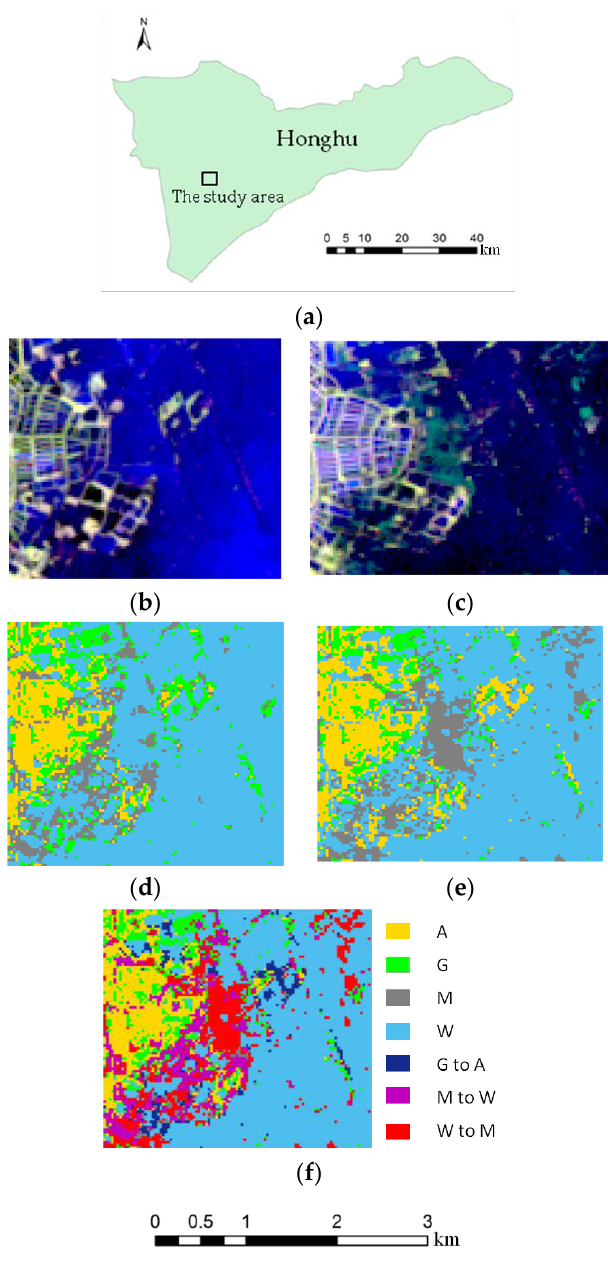
Figure 1. The study area, the images used and the maps derived: ( a ) the study area; ( b , c ) sub-scene Landsat ETM+ images for 2012 and 2013, respectively; ( d , e ) land cover classification maps showing 4 classes of land cover for 2012 and 2013, respectively; and ( f ) land cover change map derived from the bi-temporal image data, showing 7 classes including 4 unchanged and 3 changed classes. In (d,e,f), A, G, M and W indicate arable land, grass land, mixed land cover and water bodies, respectively. Two sub-scene Landsat ETM+ images of Honghu municipality, flown on 17 May 2012 (Time 1) and 8 August 2013 (Time 2) with Bands 1 to 5 and 7 at 30-m resolution, respectively, were used